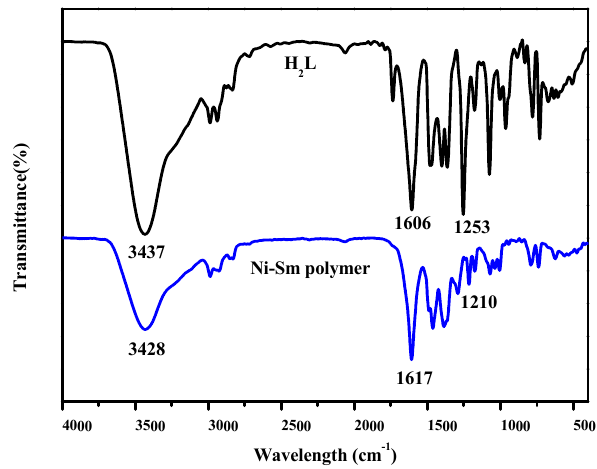
Figure 2. Infrared spectra of H 2 L and its Ni(II)-Sm(III) coordination polymer.